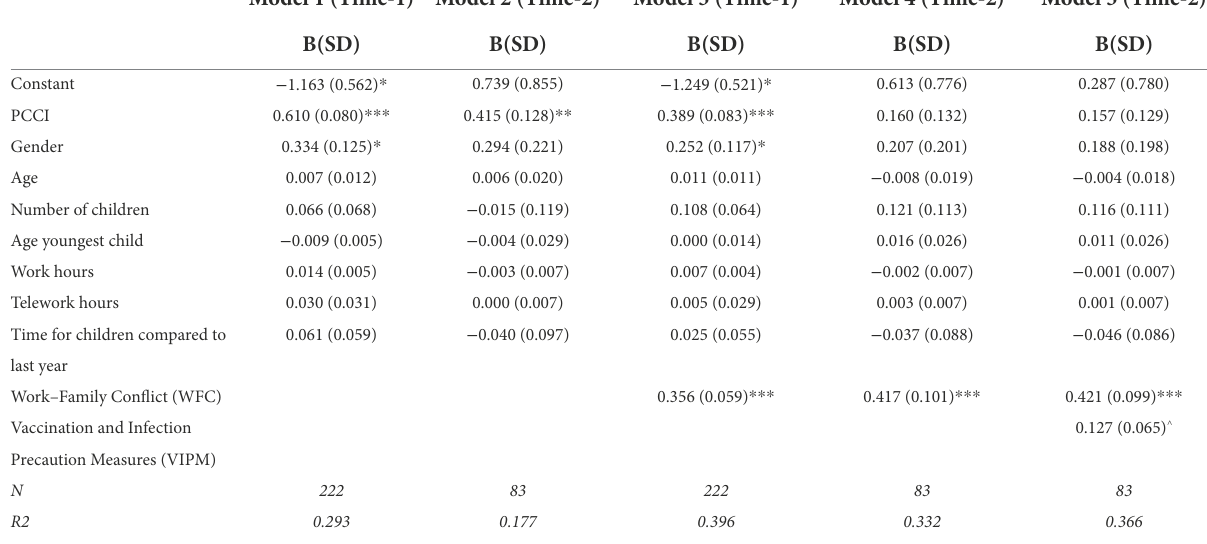
TABLE 2 Regression analysis on parental burnout (Y).